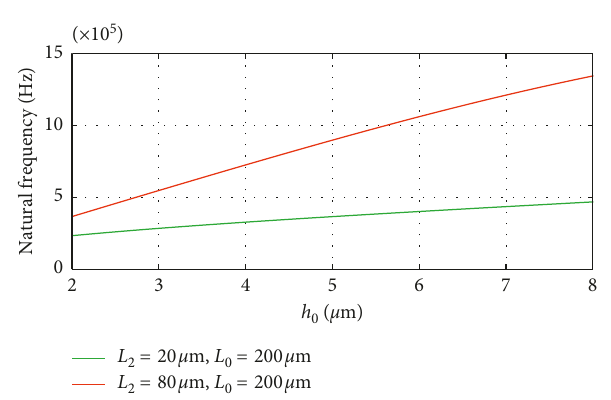
Figure 9: Natural frequency versus h